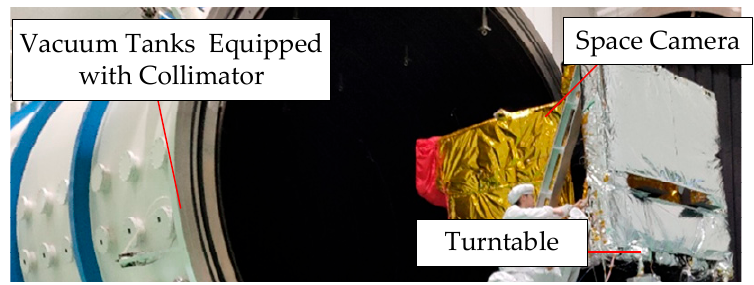
Figure 13. Test site of the modulation transfer function (MTF).